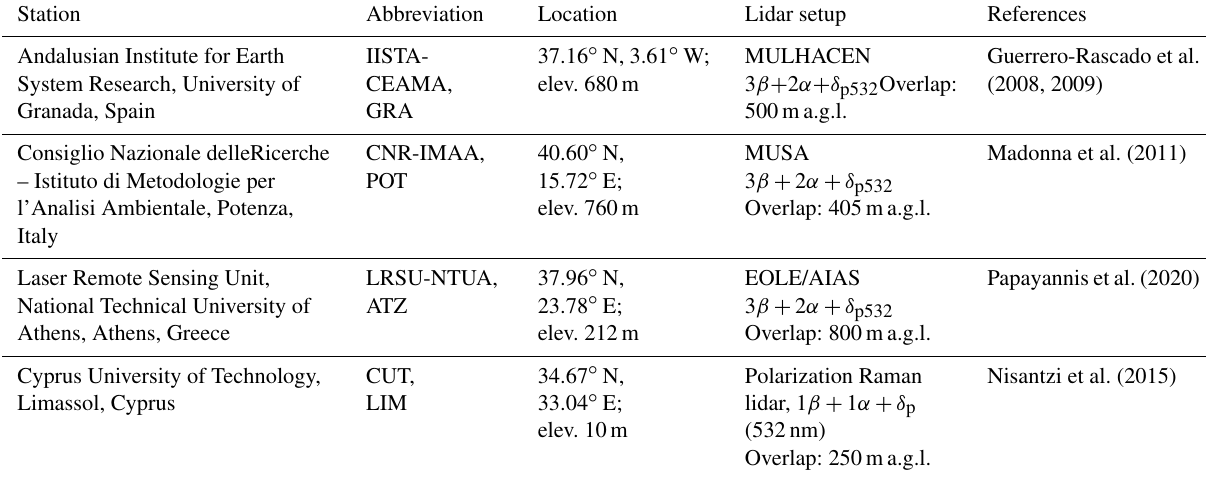
Table 1. Station name, location, lidar setup and relevant references of the four selected EARLINET stations.